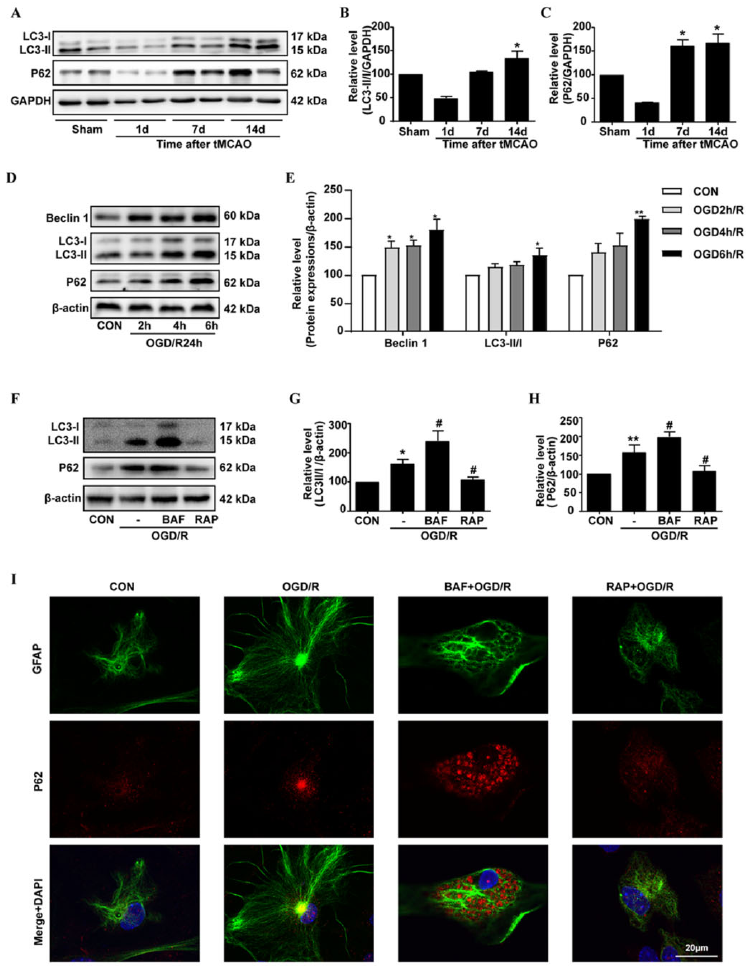
Figure 2. Autophagic flux dysfunction promotes the astrocyte activation after brain ischemia in vivo and in vitro. ( A – C ) The immunoblotting analysis and quantification of autophagy markers LC3-II/I and p62 in brain tissues after tMCAO in mice. Data are expressed as the mean ± SEM; n = 3; and * p < 0.05 vs. sham group. ( D , E ) The immunoblotting analysis and quantification of Becline1, p62, and LC3-II/I in astrocytes after exposure to the different times of OGD and then reoxygenation for 24 h. ( F – H ) The immunoblotting analysis and quantification of p62 and LC3-II/I in the astrocytes exposed to OGD/R after pretreatment with rapamycin (RAPA, 200 nM) or bafilomycin A1 (BAF, 500 nM). RAPA was used to induce autophagy, and BAF was used to prevent lysosomal acidification and to inhibit the autophagic flux in astrocytes, respectively. ( I ) The representative photographs of the immunofluorescence staining of GFAP (green) and p62 (red) with DAPI (blue) staining in astrocytes were exposed to OGD/R after pretreatment with RAPA or BAF. OGD/R means OGD for 6 h and reoxygenation for 24 h. The data are representative of the three independent experiments and are expressed as the mean ± SEM. * p < 0.05, ** p < 0.01 vs. normal control group; # p < 0.05 vs. OGD/R control group. OGD/R means OGD for 6 h and reoxygenation for 24